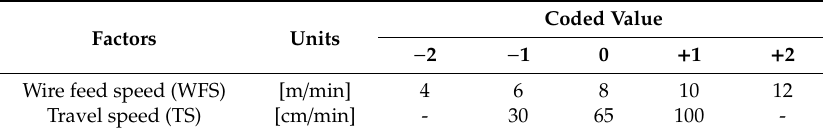
Table 1. Test battery of GMAW-PULS in ER70.